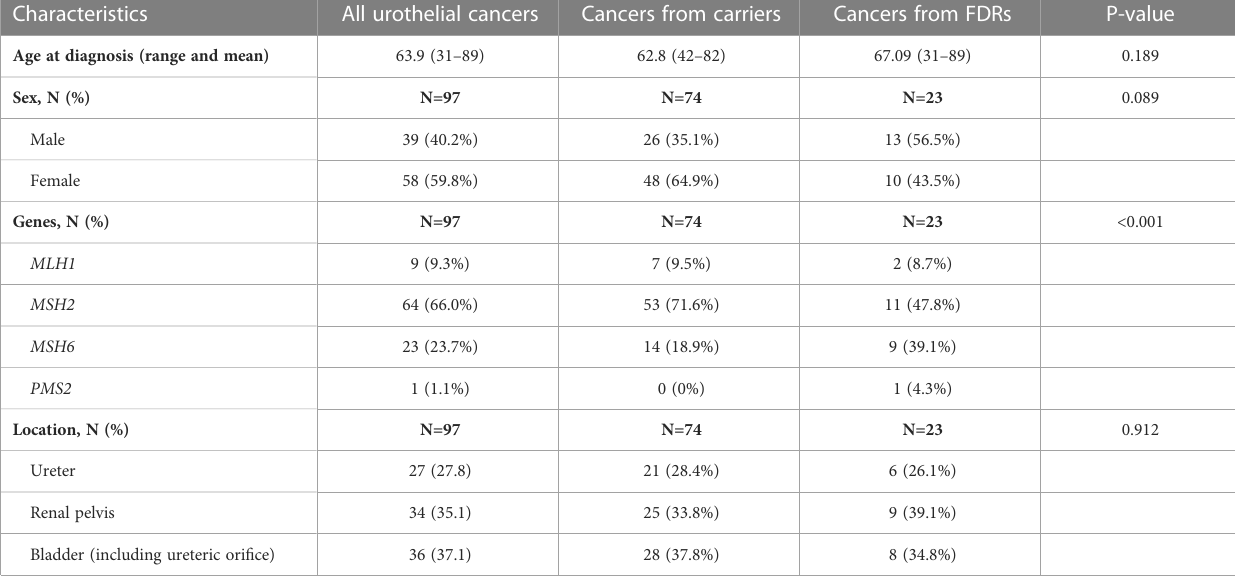
TABLE 1 Clinical data of Lynch syndrome-associated urothelial